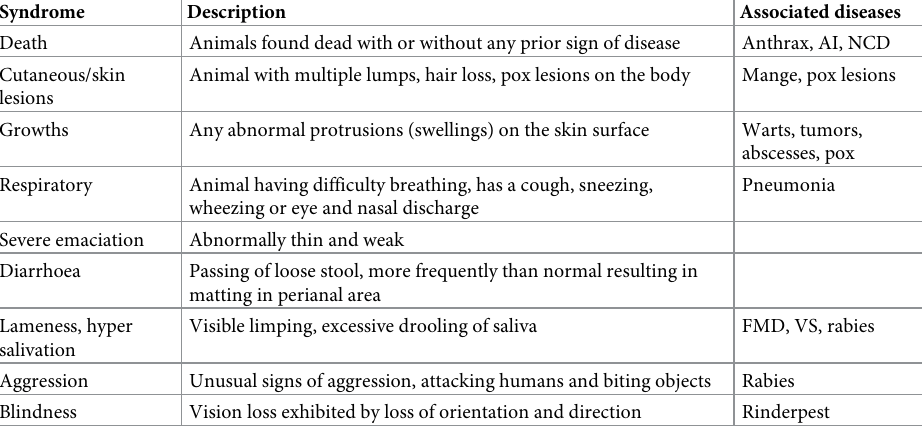
ND-1 and zero report forms) in the application. Since the Kenya Wildlife Service (KWS) did not have a disease surveillance system, we jointly developed a wildlife disease-reporting tool. Working with veterinarians from the KDVS and KWS, two separate lists of domestic animals (Table 1) and wildlife (Table 2) disease syndromes for reporting were developed. Selection of reporting syndromes was guided by the World Organization for Animal Health’s (OIE) list of notifiable diseases, important trans-boundary animal diseases in sub-Saharan Africa, and endemic and emerging zoonotic diseases in the region [19]. Table 2. Syndromes in wildlife automatically reported using KABS mobile phone application in Kenya, 2017–